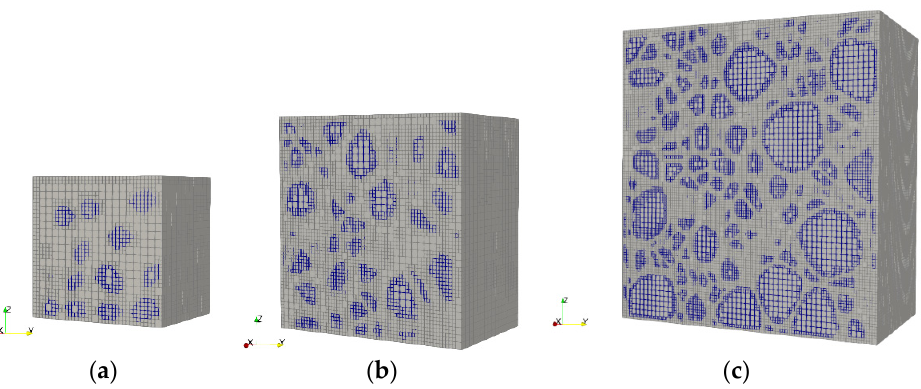
Figure 7. Typical octree mesh of aggregates and matrix of wet-screened ( a ), three-graded ( b ), and fully graded ( c ) concrete samples.